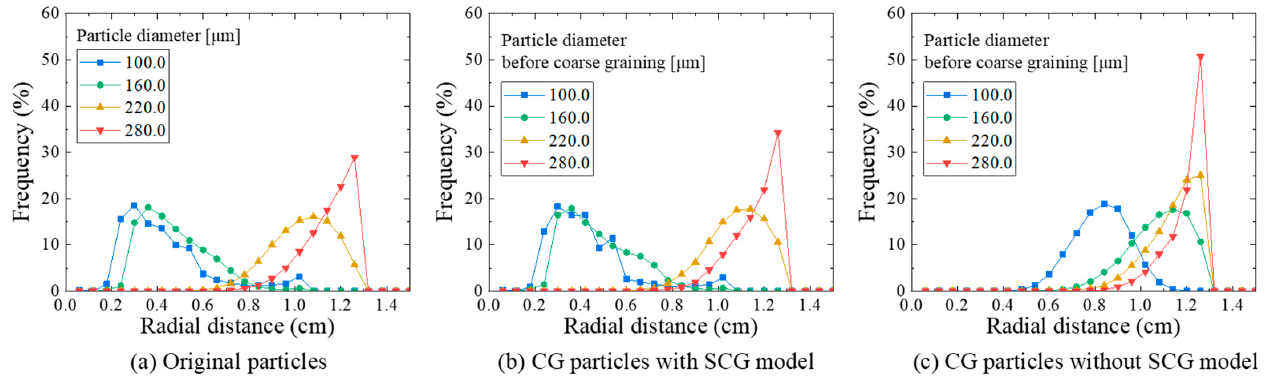
Figure 10. Radial distance distributions for each particle diameter in the classifier.